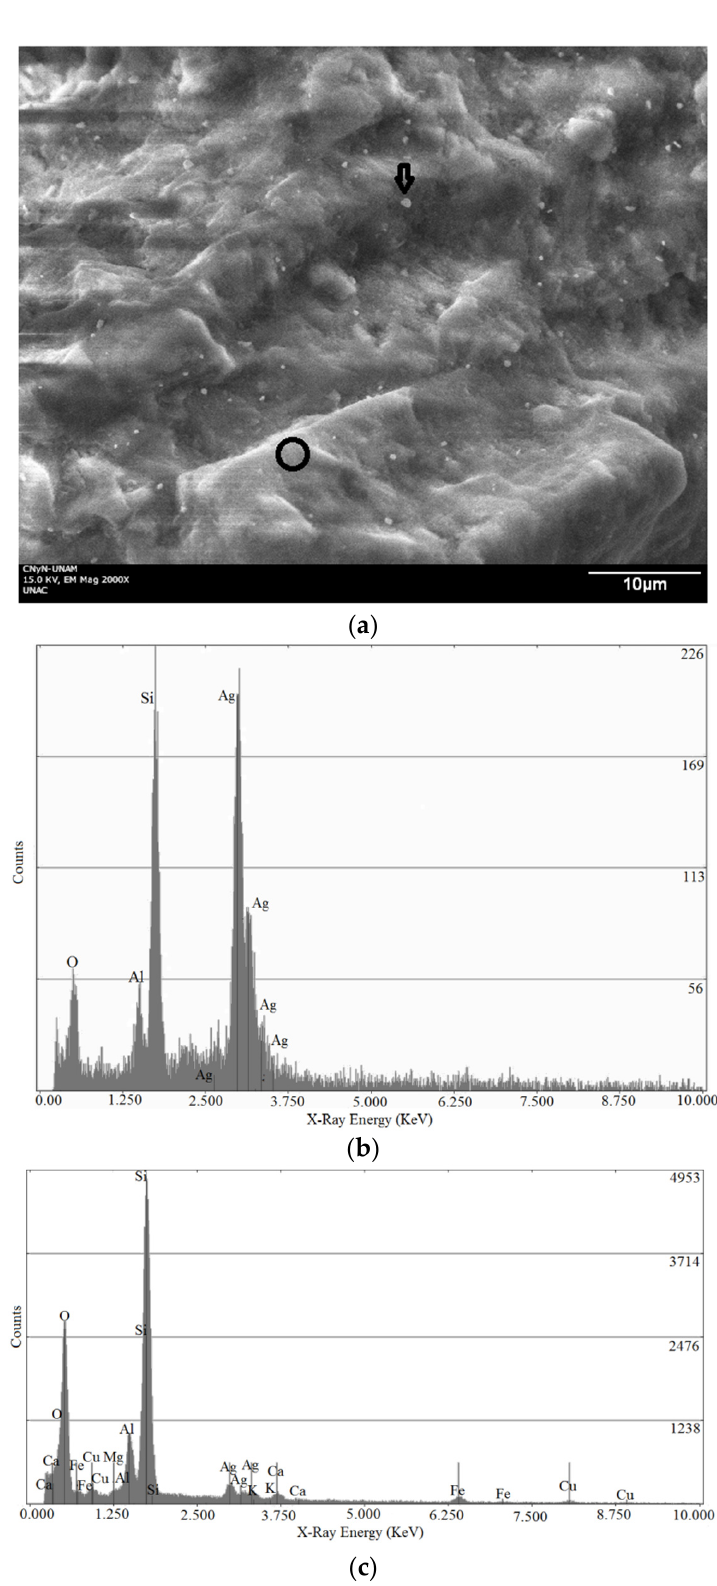
Figure 5. SEM image ( a ) of the aged Cu3Ag1CLI Hydrot sample, showing the presence of silver particles on sample surface. EDS spectra obtained on a silver particle (indicated with black arrow in ( a )) and on zeolite matrix zone (indicate with black circle in ( a )) are shown in ( b ) and ( c ) respectively.